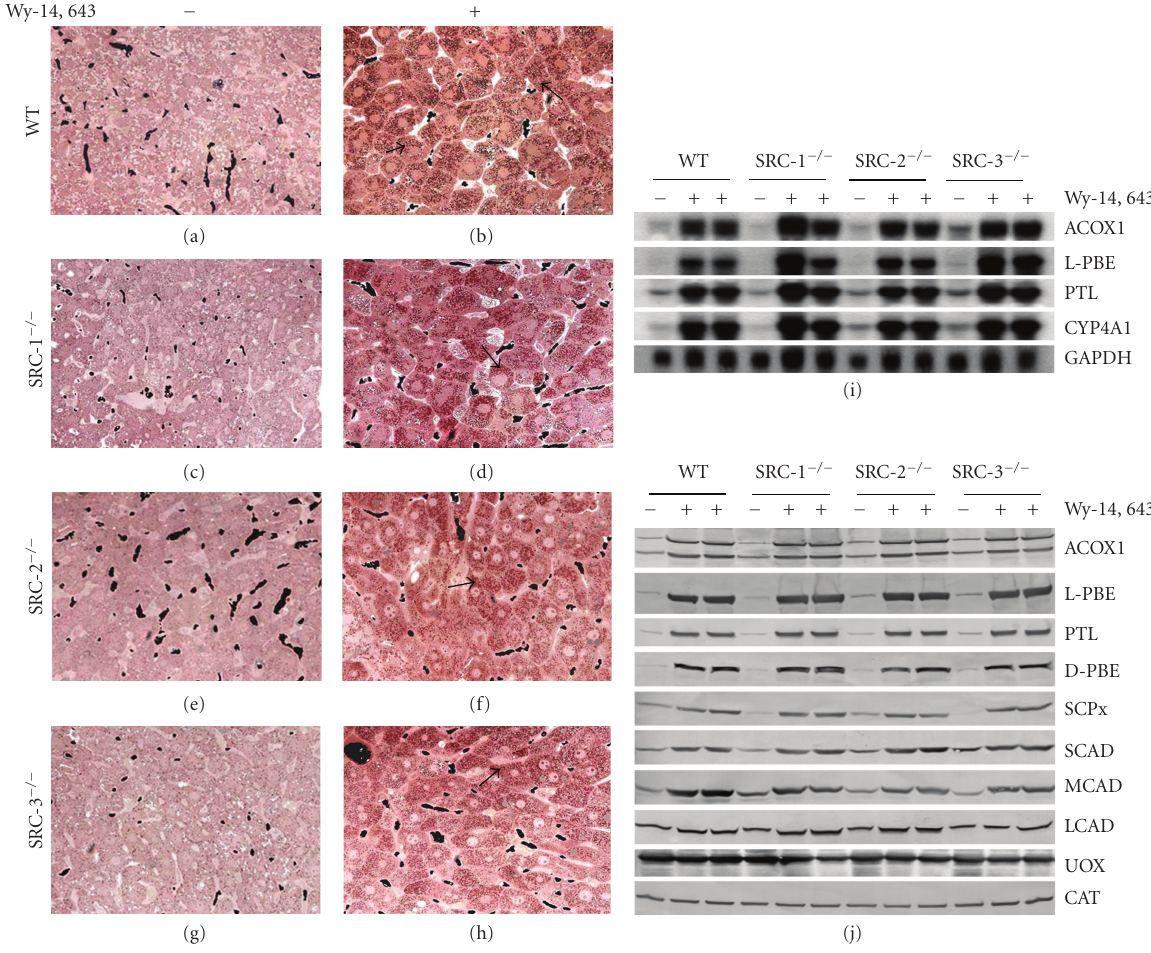
Figure 2: (a–h) Peroxisome proliferation in liver cells of wild-type (WT), SRC-1 − / − SRC-2 − / − and SRC-3 − / − mice treated with Wy-14,643 for 4 days. Liver sections were processed for the cytochemical localization of peroxisomal catalase by using alkaline 3 (cid:2) ,3 (cid:2) -diaminobenzidine substrate. Control diet (upper panels; a, c, e, g). Wy-14,643 diet (lower panels; b, d, f, h). Peroxisomes appear as brown dots (arrows) distributed throughout the cytoplasm in these 0.5 μ m thick sections. All mice, wild-type and SRC nulls displayed extensive peroxisome proliferation after treatment with Wy-14, 643 indicating that these coactivators are not required for PPAR α -regulated pleiotropic responses including fatty acid oxidation. (i) Northern blot analysis to confirm changes in mRNA expression of peroxisomal and microsomal fatty acid metabolizing enzymes in wild-type and SRC nulls after 4-days treatment with PPAR α ligand Wy-14, 643. All genes are regulated by PPAR α . Fatty acyl-CoA oxidase-1 (ACOX1), peroxisomal enoyl-CoA hydratase/3-hydroxyacyl-CoA dehydrogenase bifunctional enzyme (L- PBE), and peroxisomal thiolase (PTL) represent peroxisomal β -oxidation system while CYP4A1 is involved in microsomal ω -oxidation of fatty acids. GAPDH is used as an indicator of RNA loading. (j) Western blot analysis from the above-mentioned livers was used to verify the degree of expression of peroxisomal and mitochondrial fatty acid metabolizing enzymes in wild-type and SRC knockout mice. Liver homogenates (20 μ g) from each group of mice were run on 4–20% SDS PAGE gel and immunoblotted using antibodies for peroxisomal (ACOX1, L-PBE, PTL, D-PBE, and SCPx) and mitochondrial (SCAD, MCAD, and VLCAD) fatty acid metabolizing enzymes. No di ff erence in the induction was observed between SRC nulls and wild-type for the β -oxidation